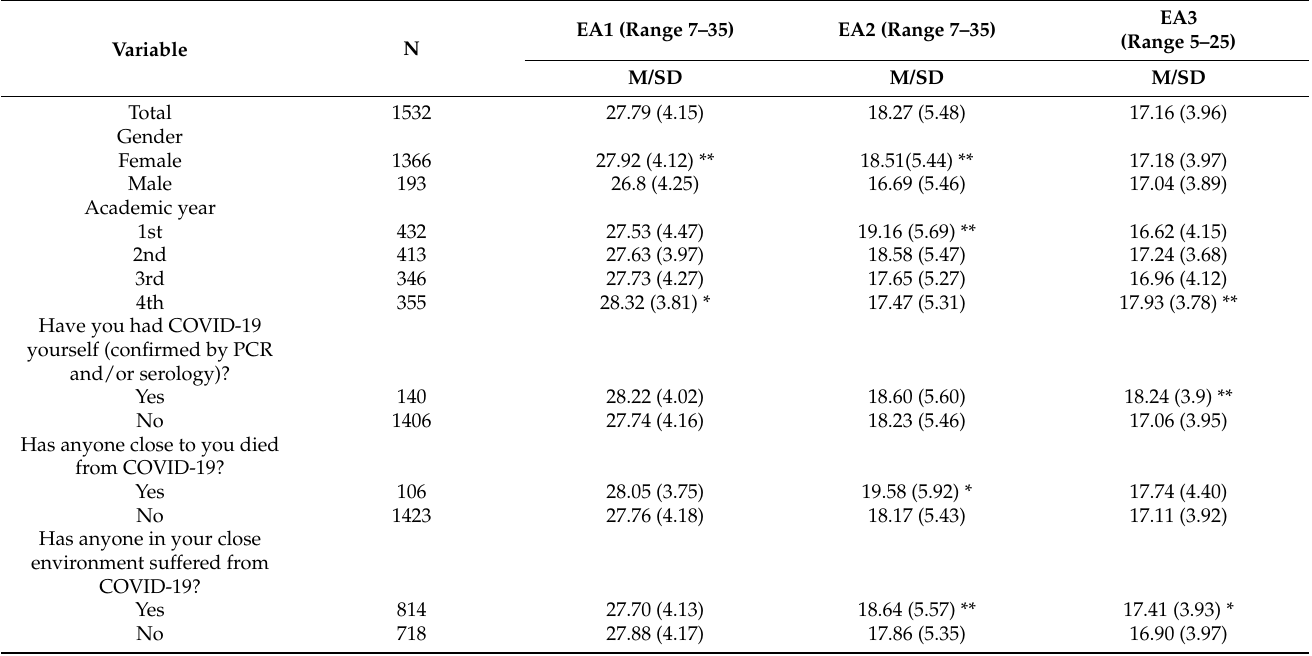
Table 3. COVID-19 coping styles. EA1 (situation-focused coping style); EA2 (avoidance coping style); EA3 (support-seeking coping